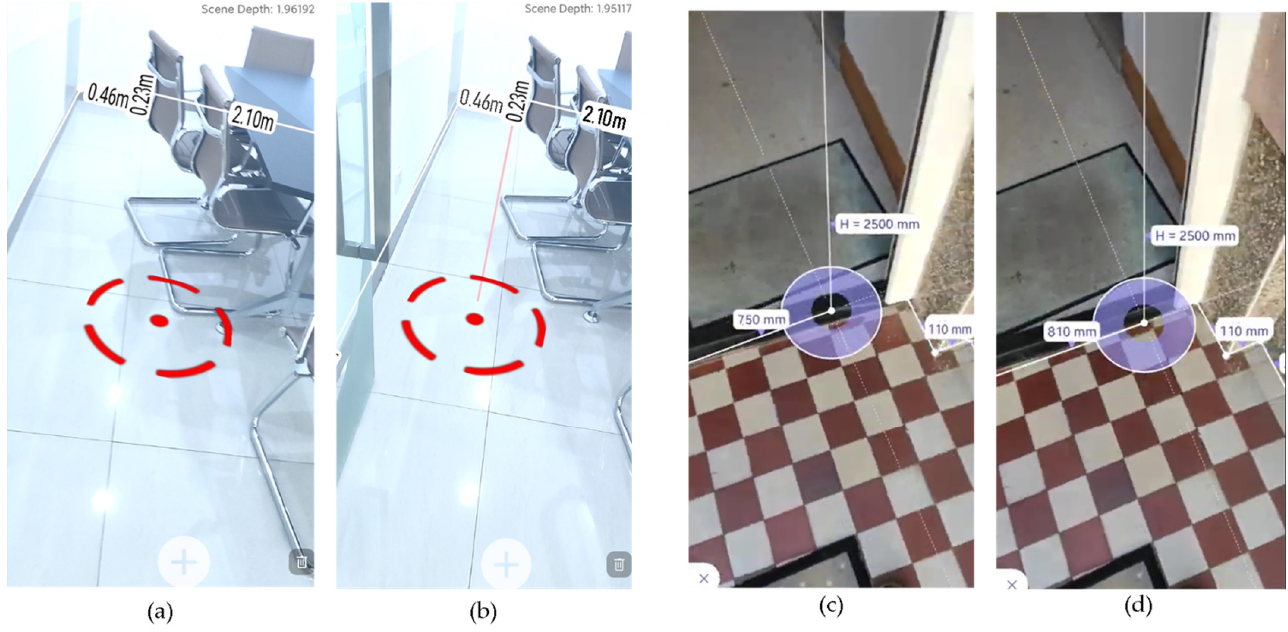
Figure 12. Capturing the extended lines and horizonal lines in 3D space: ( a ) before snapping the extended lines; ( b ) after snapping the extended lines; ( c ) before snapping the horizonal lines; ( d ) after snapping the horizonal lines.